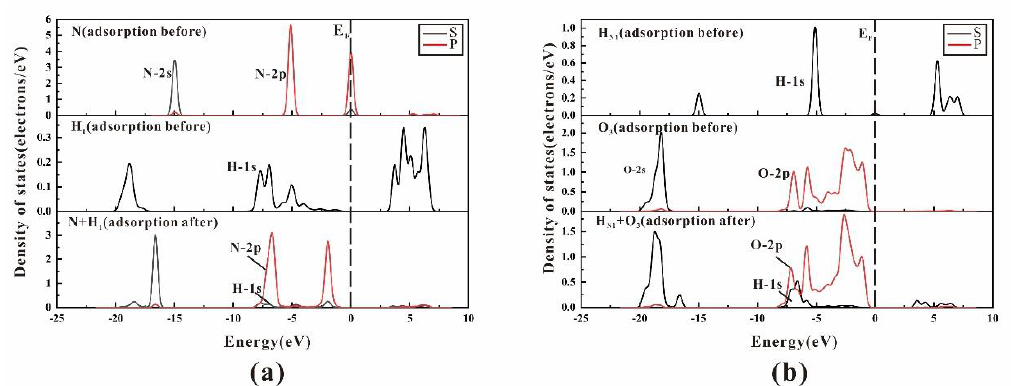
Figure 8. The PDOS plots of atoms before and after NH 3 adsorption on kaolinite (001) surface: ( a ) is the partial density of states plot of the H 1 atoms on kaolinite (001) surface and N atoms in NH 3 ; ( b ) is the partial density of states plot of the H N1 in NH 3 and O 1 on kaolinite (001) surface.